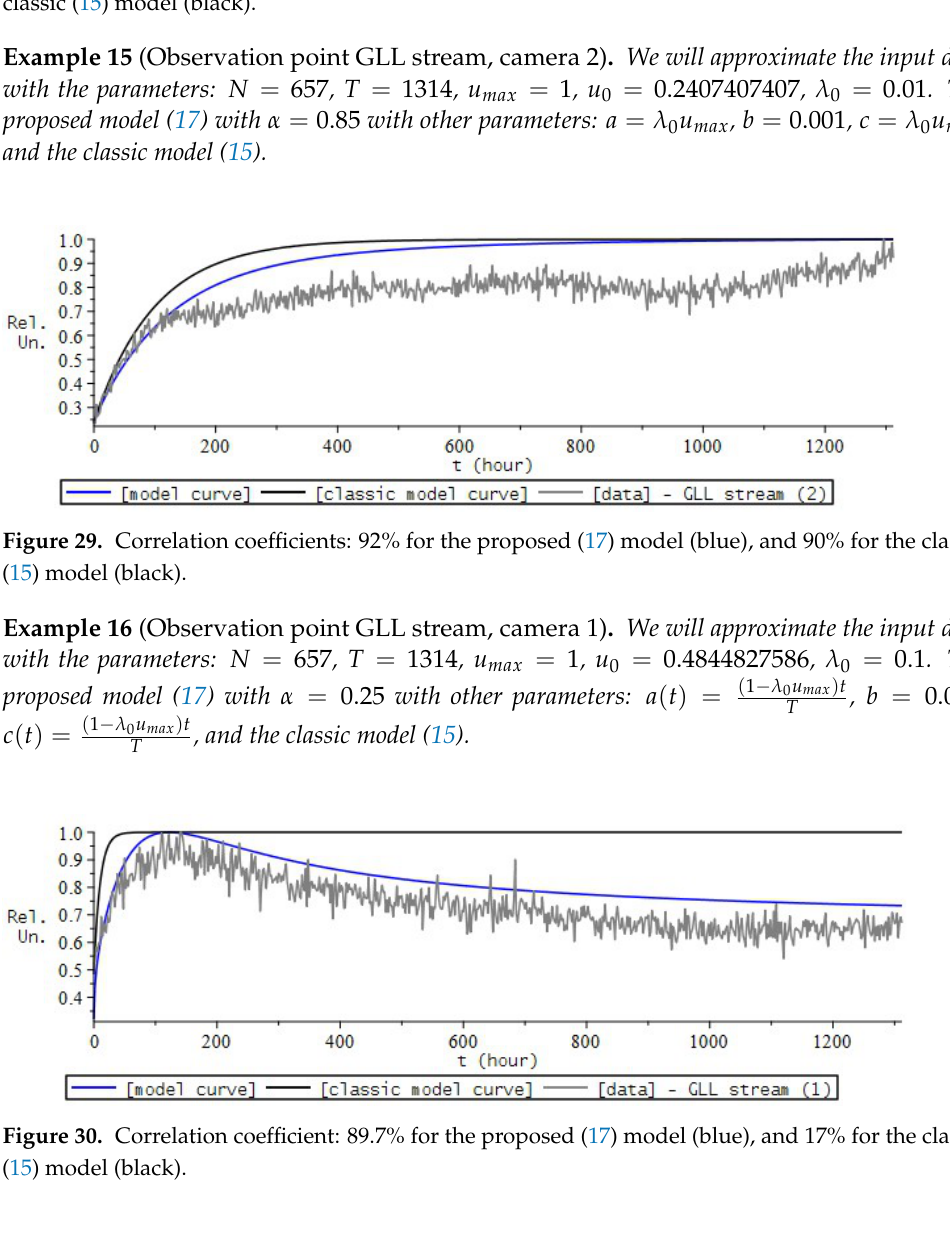
Figure 28. Correlation coefficients: 98.6% for the proposed (17) model (blue), and 98.9% for the classic (15) model (black).